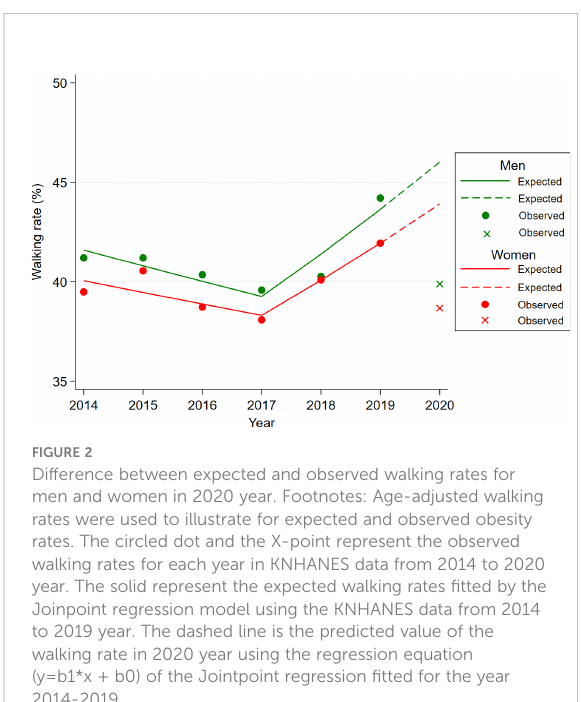
FIGURE 1 Difference between expected and observed obesity rates for men and women in 2020 year. Footnotes: Age-adjusted obesity rates were used to illustrate for expected and observed obesity rates. The circled dot and the X-point represent the observed obesity rates for each year in KNHANES data from 2014 to 2020 year. The solid represent the expected obesity rates fi tted by the Joinpoint regression model using the KNHANES data from 2014 to 2019 year. The dashed line is the predicted value of the obesity rate in 2020 year using the regression equation (y=b1*x + b0) of the Jointpoint regression fi tted for the year 2014-2019. lower than that in 2019, after adjusting for all covariates.